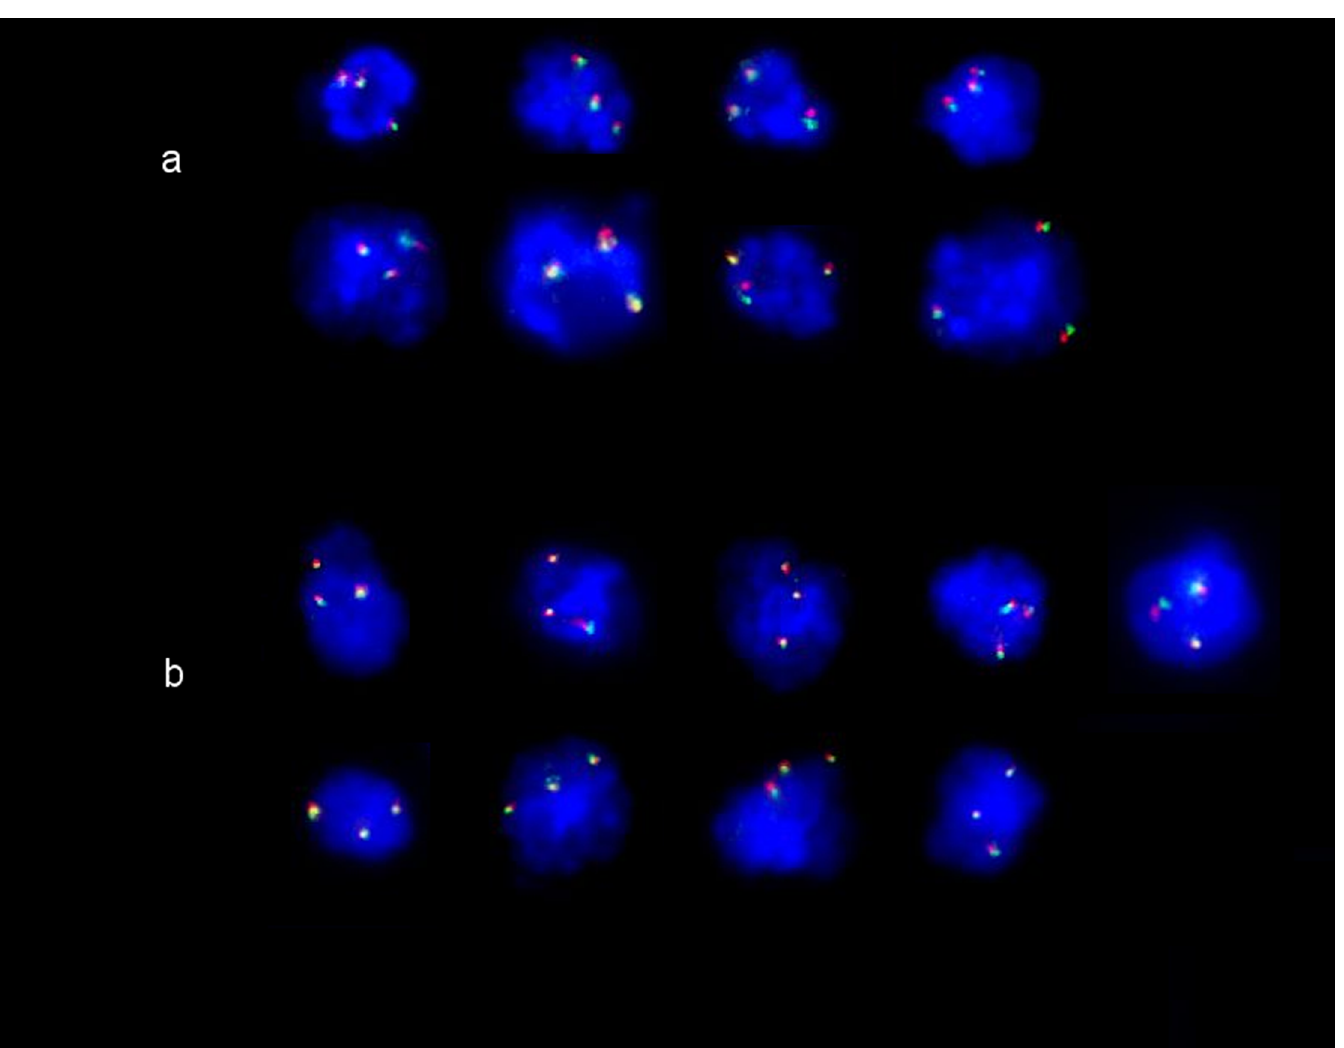
Fig 2. FISH signals on fetal cells in maternal blood. a) Dual-probe FISH analysiswith two probes for different loci on chromosome 18 shows three signals in green and three in red in a pregnantwoman with a trisomy 18 fetus; b) FISH analysiswith two probes for chromosome 21 showingthree signals in green and three in red specific for two different loci of chromosome 21 in a woman with a trisomy 21 fetus.